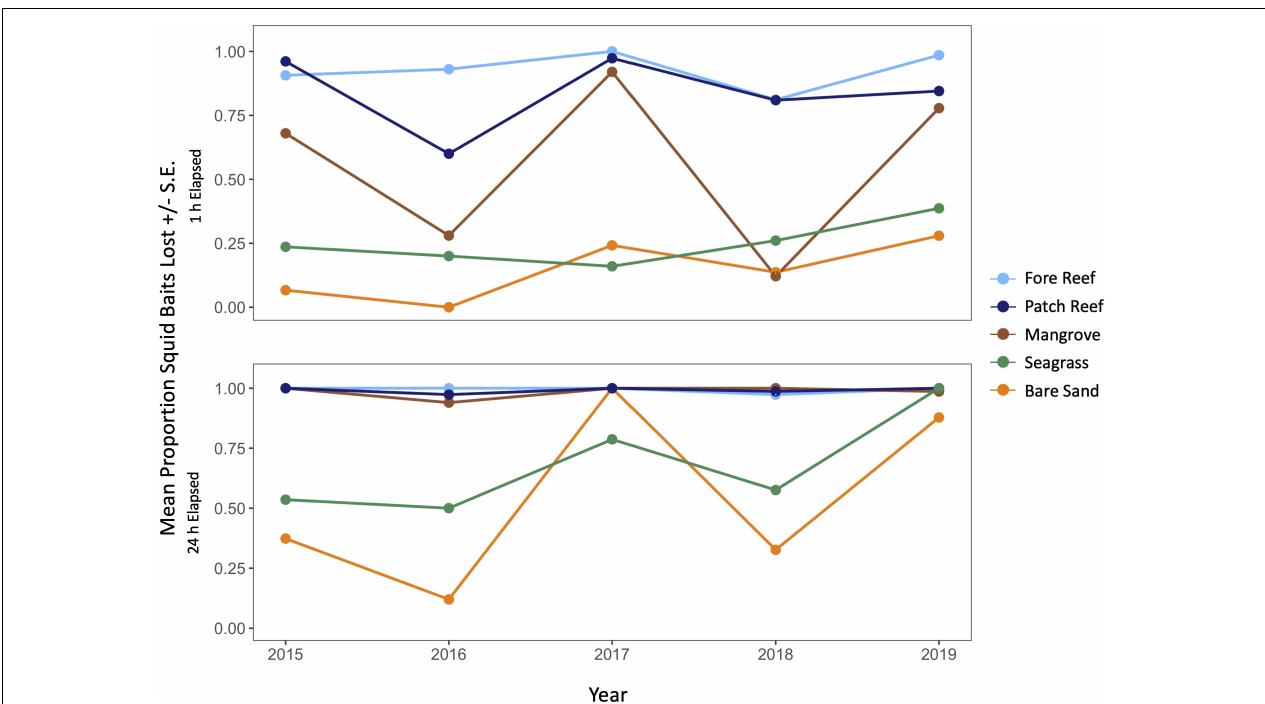
FIGURE 4 | Mean proportion of squid baits consumed after 1 and 24 h ( ± 1 S.E.) across each year of the study, parsed by habitat.